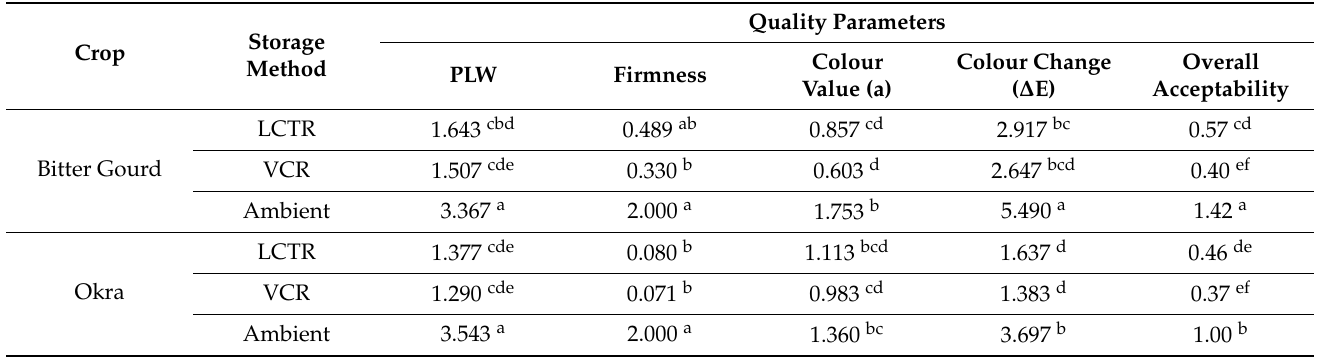
Table 2. Statistical significance for the interaction of storage method and crop for average daily changes in quality parameters of the